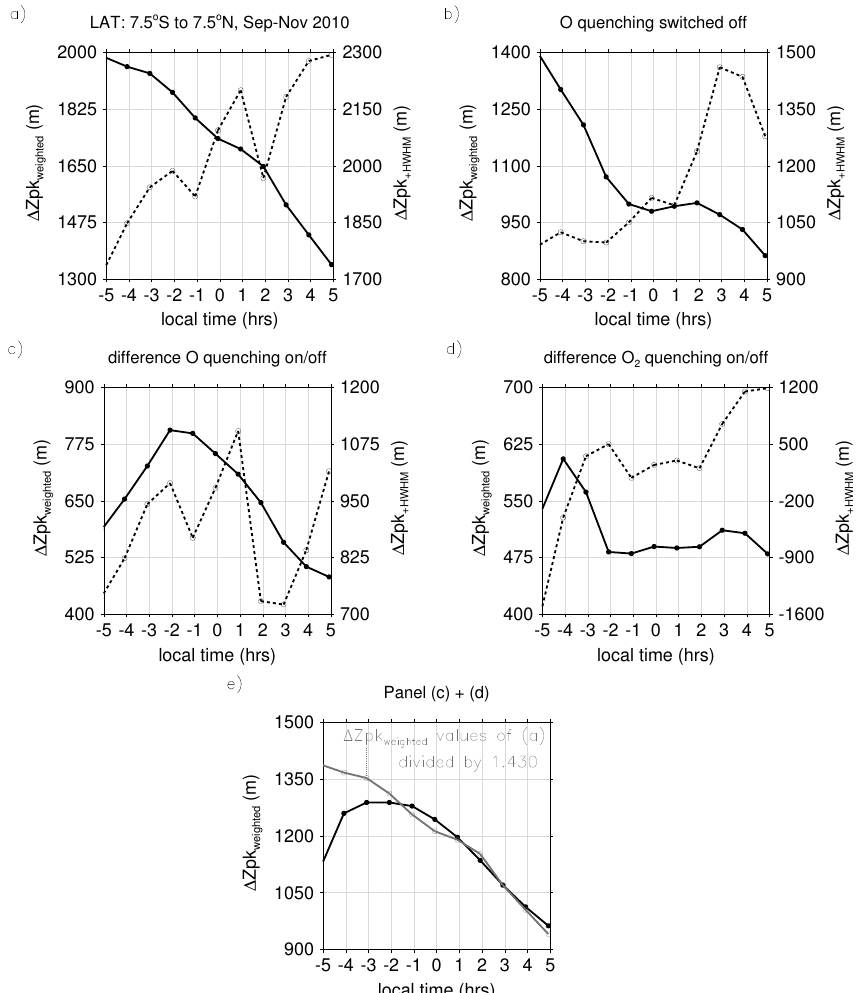
Figure 7. Simulated diurnal evolution of vertical OH(9;5) profile shifts at equatorial latitudes for the same averaging time as in Fig. 6. (a) Fig. 7: Simulated diurnal evolution of vertical shifts at equatorial latitudes for the same averaging Vertical shifts based on a model run including all quenching terms. The solid line refers to peak shifts with respect to weighted peak altitudes time as in Fig. 6. Panel (a): vertical shifts based on a model run including all quenching terms. The (Eq. 4), the dashed line refers to vertical shifts with respect to peak altitudes + HWHM (Eq. 5). (b) Vertical shifts based on a model run with deactivated O quenching. (c) Difference between (a) and (b) . (c) Difference between a full quenching model run and a model run with solid line refers to peak shifts with respect to weighted peak altitudes (Eq. 3), the dashed line refers deactivated O 2 quenching. (e) Sum of (c) and (d) (black line). (f) Full peak width of the vibrationally integrated OH( ν ) layer. (f) /left axis: to vertical shifts with respect to peak altitudes + HWHM (Eq. 4). Panel (b): peak shifts based on a Full peak widths of OH(9) and OH(5) layers (dashed and solid grey lines). (g) /right axis: Relative difference between the full peak widths of model run with deactivated O quenching. Panel (c): Difference between Panel (a) and (b). Panel (c): the OH(9) and OH(5) layers (black solid Difference between a full quenching model run and a model run with deactivated O 2 quenching. Panel (e): Panel (c) + (d) (black line). Panel (f): Full peak width of the vibrationally integrated OH( ν ) layer. Panel (f)/left axis: Full peak widths of OH(9) and OH(5) layers (dashed and solid grey lines). Panel (g)/right axis: Relative difference between the full peak widths of the OH(9) and OH(5) layers (black solid line).